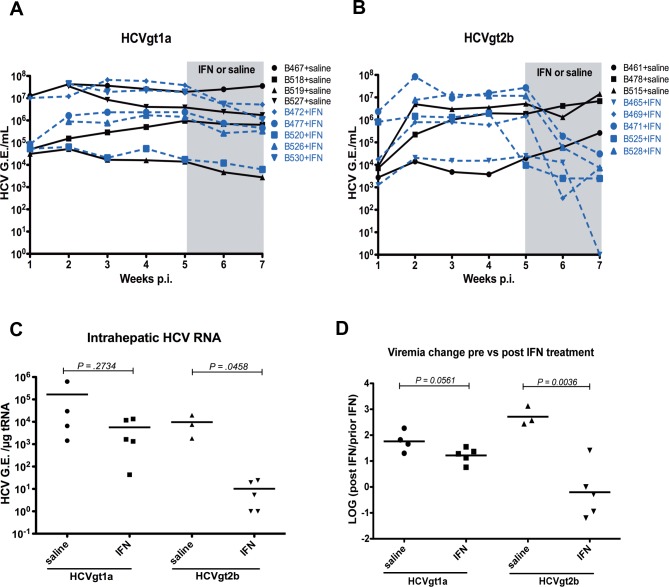
Responses of the two HCV strains to IFNα in mice populated with a single donor.We infected chimeric mice produced with a single hepatocyte donor, Hu8063, with 2 HCV strains for 5 weeks. We then subcutanously injected exogenous human IFNα-2b daily at 1,350 IU/gram for 14 days. We treated control chimeric mice with saline. We took sera from the mice weekly in order to measure viremia. Six hours after the last IFNα injection, we terminated the mice and measured intrahepatic HCV load. Data for mice treated with saline are represented by black solid lines and data for mice treated with IFNα are represented by blue dashed lines in A (HCVgt1a viremia titer) and B (HCVgt2b viremia titer). Each line in A and B represents a single mouse. The period of human IFNα/saline treatment is shaded in gray. A comparison of intrahepatic HCV RNA levels for different treatment groups at week 7 p.i. is shown in C. P-values in C were calculated using unpaired t-tests.